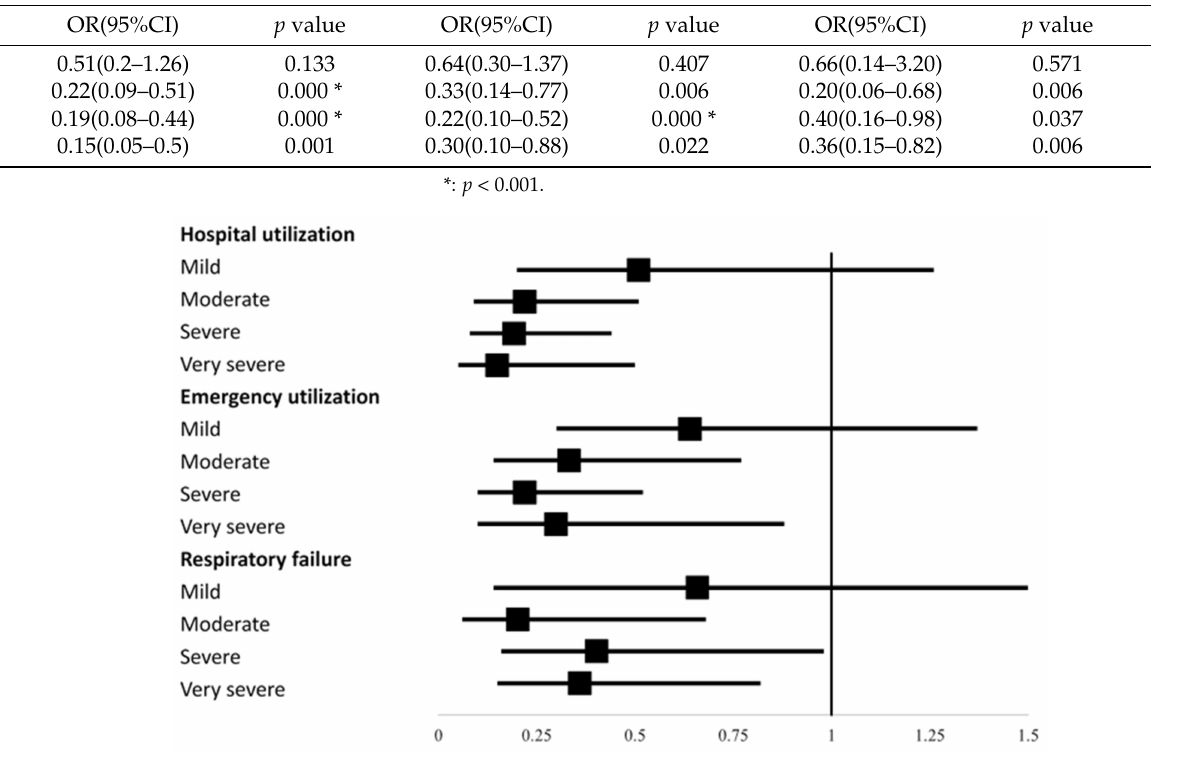
Figure 3. Adjusted odds ratio and 95% confidence interval of the likelihood of medical utiliza- tion according to influenza vaccination status among COPD patients with different severities of airflow